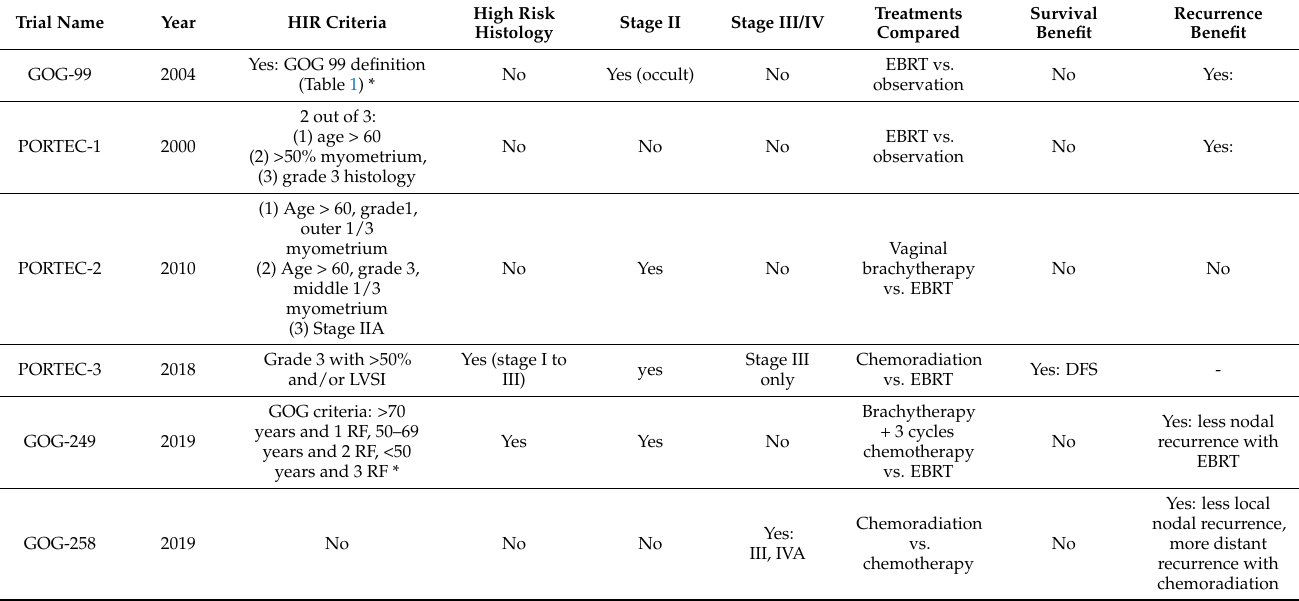
Table 2. Summary of patients included in high intermediate risk and high risk EC landmark